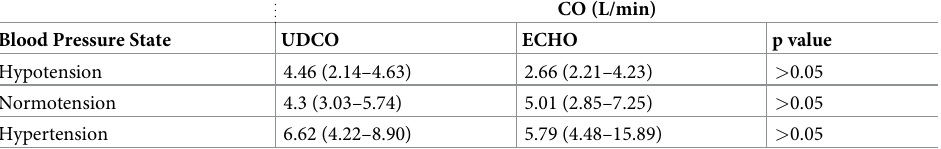
Table 4. Comparison of median (min-max) values for cardiac output measured via ultrasound dilution or M- mode echocardiography in six, isoflurane anesthetized, mature alpacas during isoflurane induced hypotension, normotension and phenylephrine infusion (0.5–3 mcg/kg/min) induced hypertension. Hypotension was defined as a mean blood pressure between 45 and 55 mmHg, normotension was defined as a mean blood pressure between 65 and 75 mm Hg and hypertension was defined as a mean blood pressure greater than 85